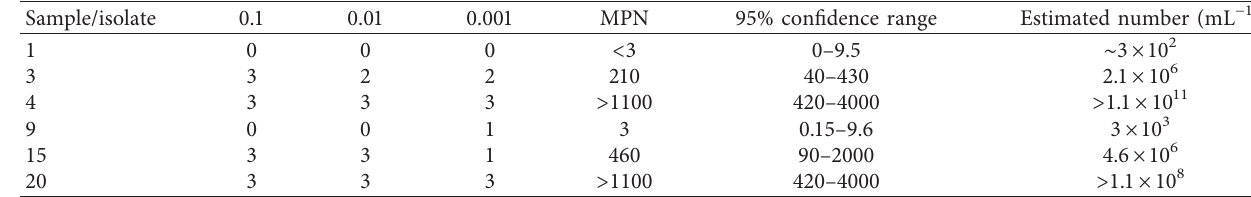
Table 2: Estimated numbers of Gram-negative bacilli in some of the tested milk samples.